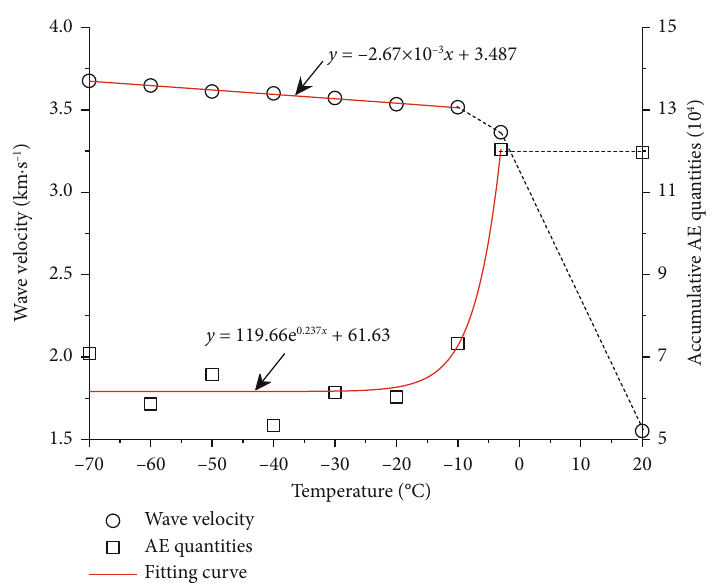
Figure 4: In fl uence of temperature on longitudinal wave velocity and AE characteristics.